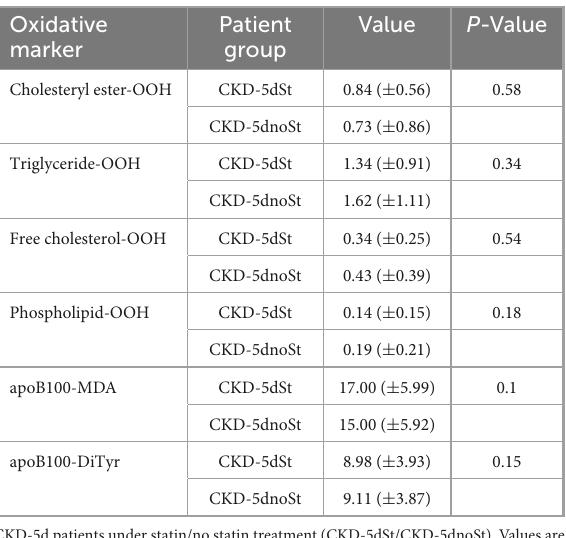
TABLE 7 Oxidation markers of LDL free cholesterol and triglyceride sub-fractions and apoB100 in CKD-5d patients under ± statin treatment.